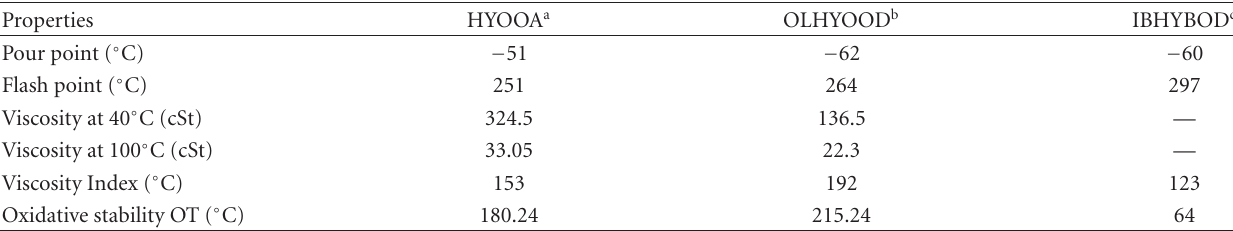
Table 8: Physicochemical characteristics of OLHYOOD.